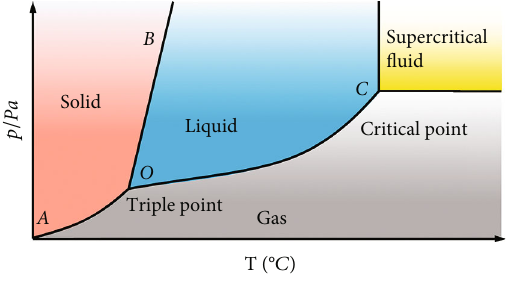
Figure 1: Phase diagram of CO